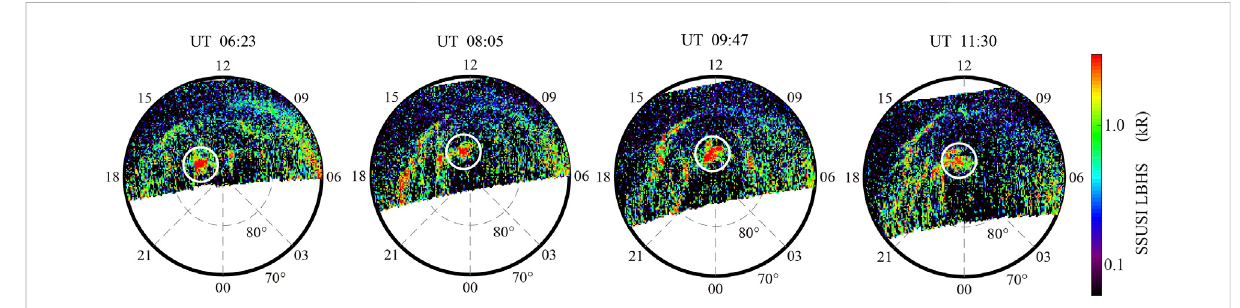
FIGURE 1 Typical spacehurricaneevent observed bytheDMSP F16/SSUSI intheNorthern Hemisphereon17June 2011.The whitecircle marks thespace